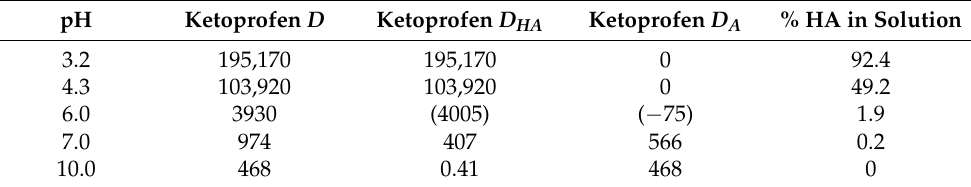
Table 2. Experimental overall distribution coefficients ( D ) of ketoprofen, determined from its pH dependent isotherms, at constant q ( q = 0.0156 mol/kg, log q = − 1.8077). The calculated distribution coefficients of the neutral ( D HA ) and ionic ( D A = D − D HA ) forms of ketoprofen, respectively, are also shown. (The small negative value of D A at pH 6.0 is contributed to uncertainties in the models used, and may be considered to be 0). The calculated pKa is